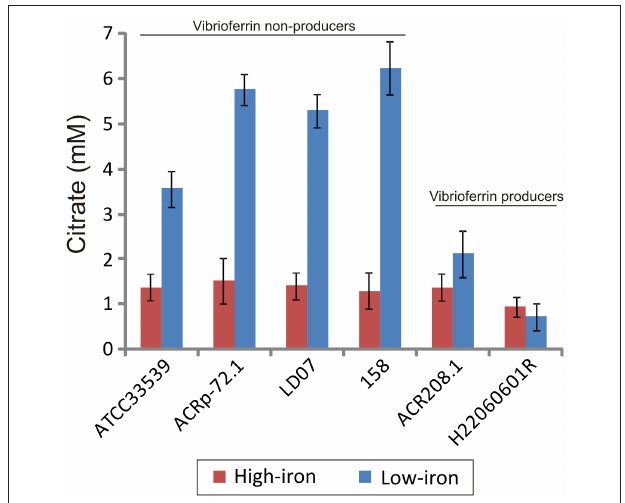
FIGURE 4 | Citrate accumulation of several representative strains of Pdd producing and non-producing vibrioferrin. Each bar represents mean values from three replicates. Error bars indicate standard